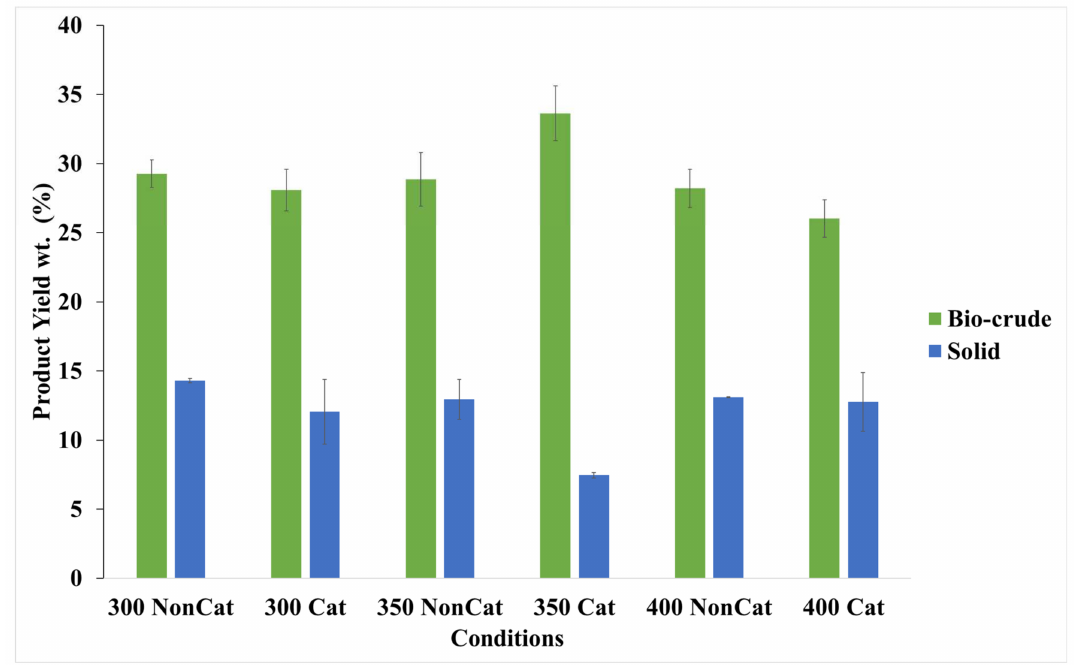
Figure 3. Product yield at Sub-Supercritical